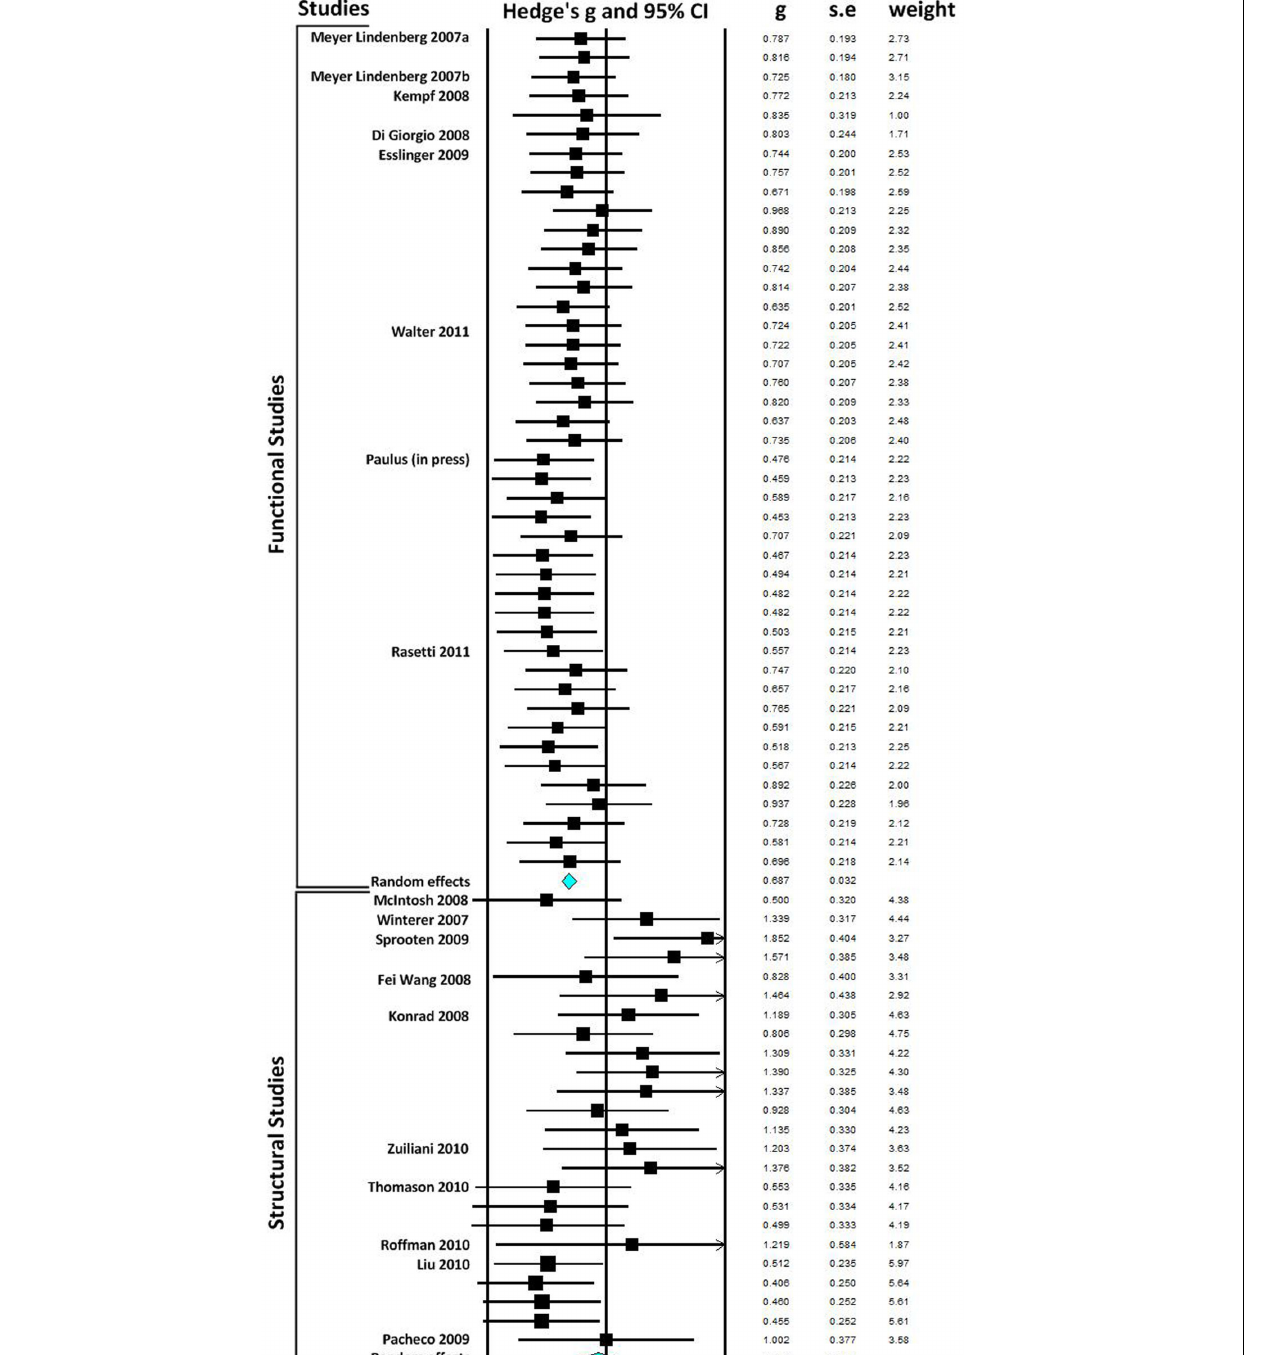
Other gene variants associated with variation in WM connec- tivity included COMT, MTHFR, 5-HTTLPR, BDNF and DISC1.